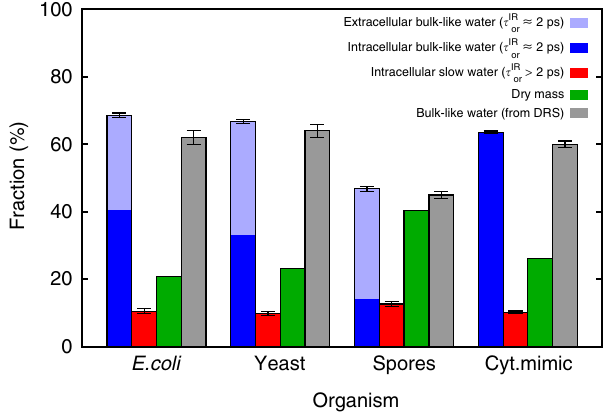
Fig. 4 Fractions of bulk-like and slow water. From the data shown in Figs. 2 and 3 we can estimate the fractions of bulk-like and slow ( τ IR the different organisms and in the cytosol mimic (pH 7, with protein). The amount of extracellular water was determined by comparing the weight of the samples before and after complete drying and using the previously reported mass fractions of intracellular water in each of the organisms. The error bars represent 1 σ , but they are lower limits of the actual uncertainties (see